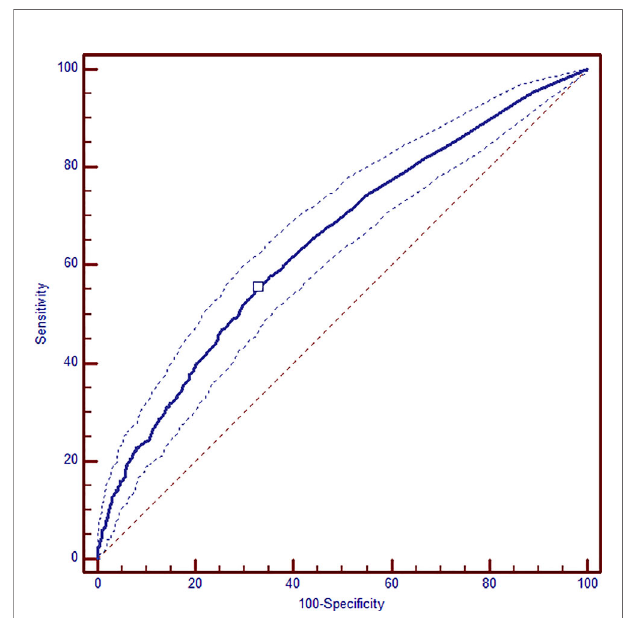
FIGURE 1 | ROC analysis of combined maternal and metabolic signi fi cant variables: altered FPG at OGTT, pre-gestational BMI >30, age >35 years, familiar history of diabetes, ART pregnancy, previous GDM, hypothyroidism. AUC 0.647 (95% CI 0.626 – 0.668); sensitivity 55.3% and speci fi city 67.3%.